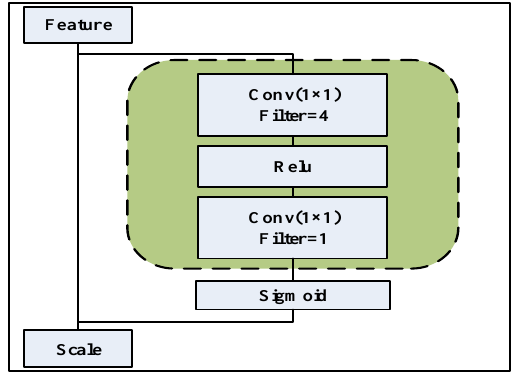
Figure 4. Structure of